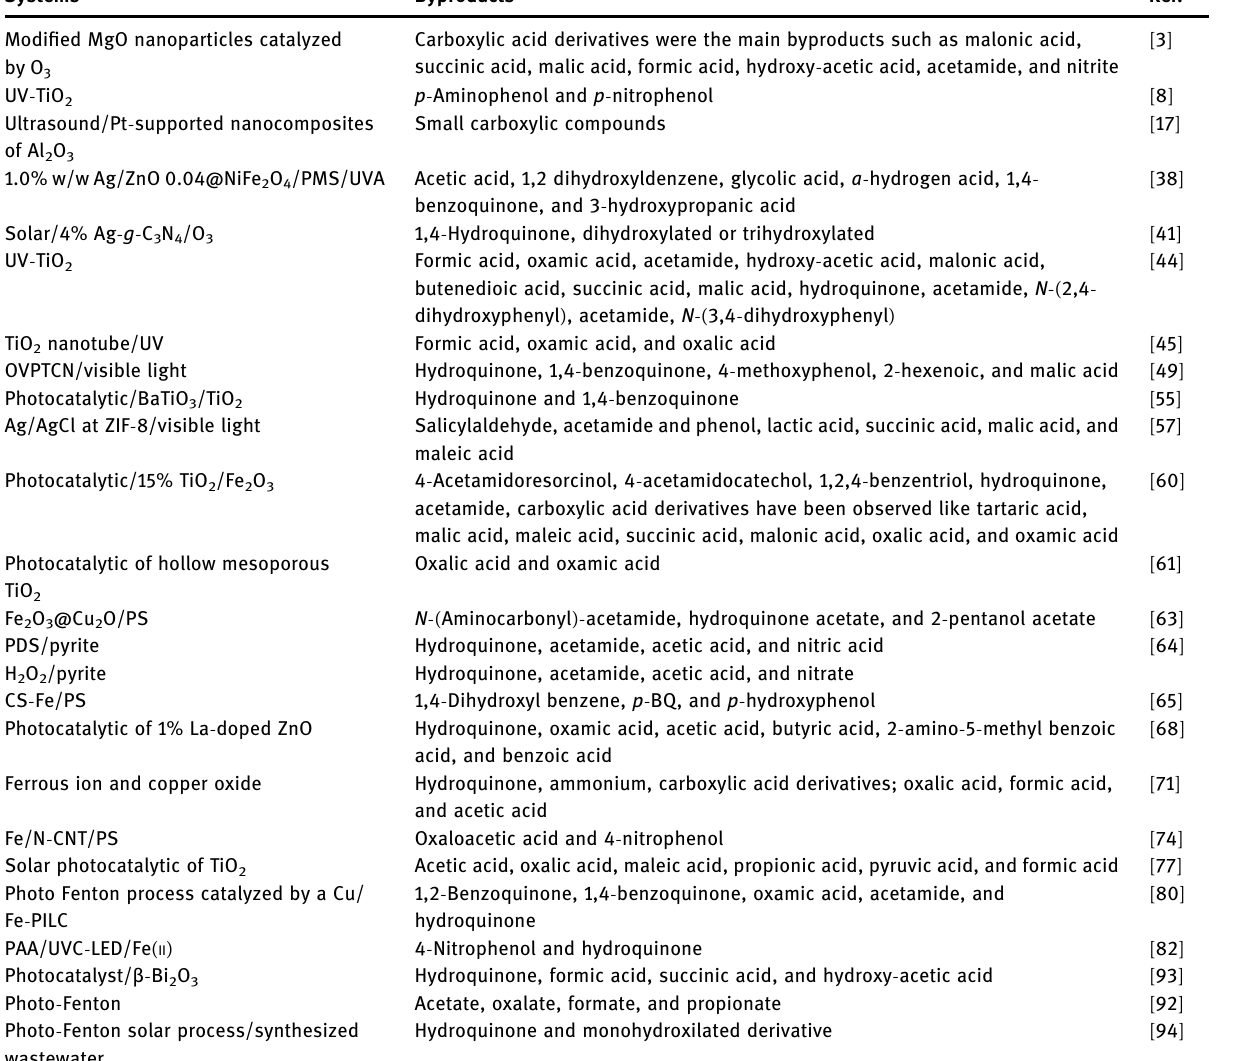
Table 6: Summary of the main byproducts that detected after ACT degradation Systems